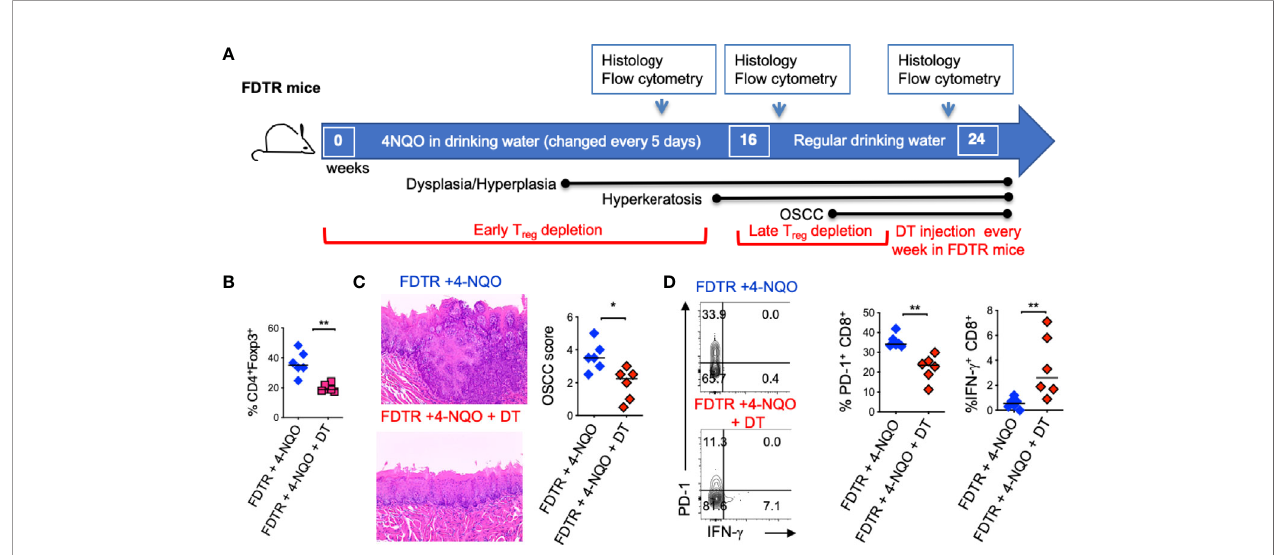
FIGURE 4 | Partial T reg depletion reduces tumor progression. T regs were depleted in FDTR mice by injecting diphtheria toxin (DT) at late time points (every 5 days between 16 th -21 st weeks of 4-NQO treatment) (A) . Statistics showing CD4 + Foxp3 + cells based on fl ow cytometry analyses at 20 and 24 weeks (B) . Immunohistochemistry H&E staining (left) and OSCC score based on invasive hyperkeratosis, and nesting (0-5) (right) (C) . Contour plots (left) and statistics (right) showing PD-1 and IFN- g expressing CD8 + T cells (D) . Mean +/- SEM in 6 mice/group (Mann-Whitney test *P < 0.05, **P <